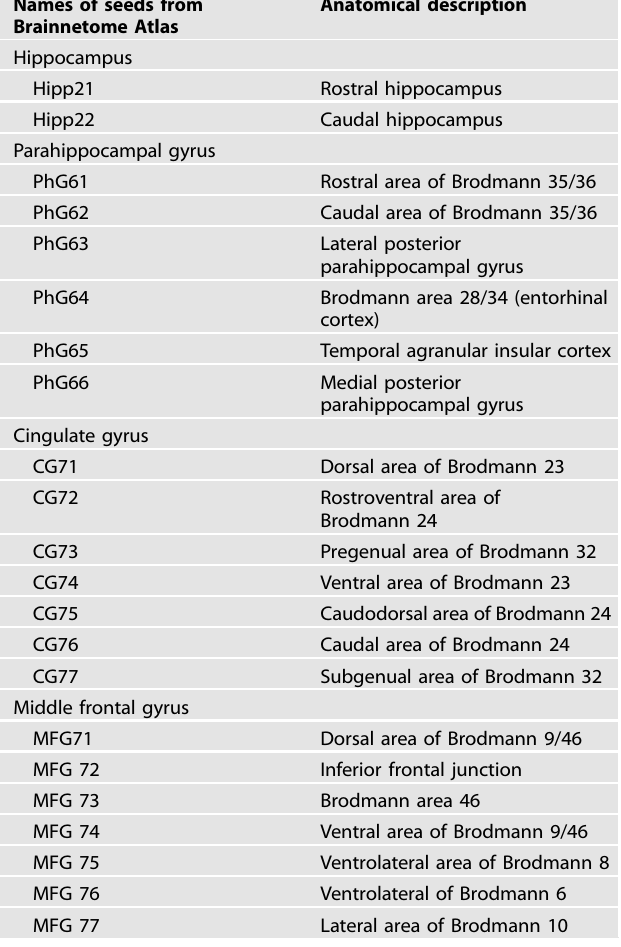
Table. 3. Results from the multivariate multiple linear regression predicting volumes of the hippocampal formation sub fi